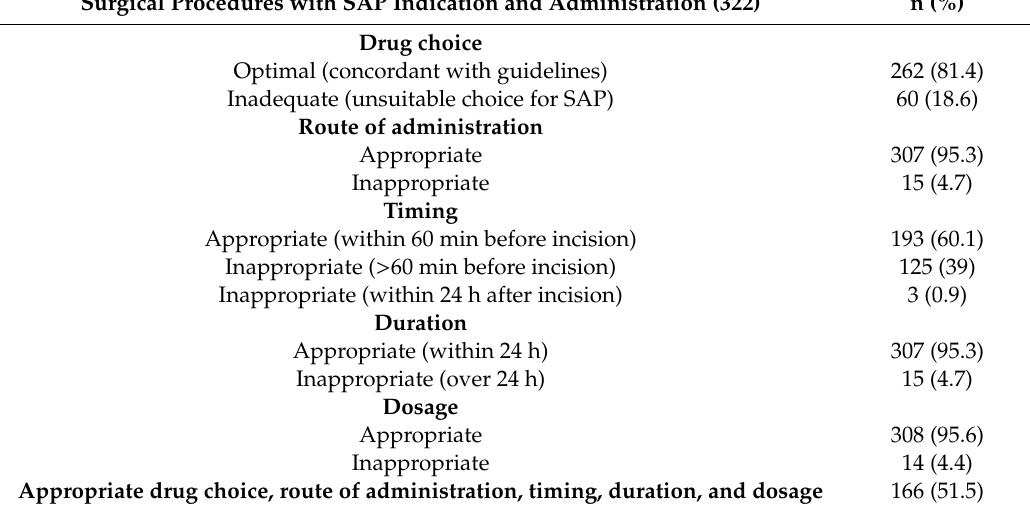
Table 2. SAP administration in procedures with indication according to drug choice, route of administration, timing, duration, and